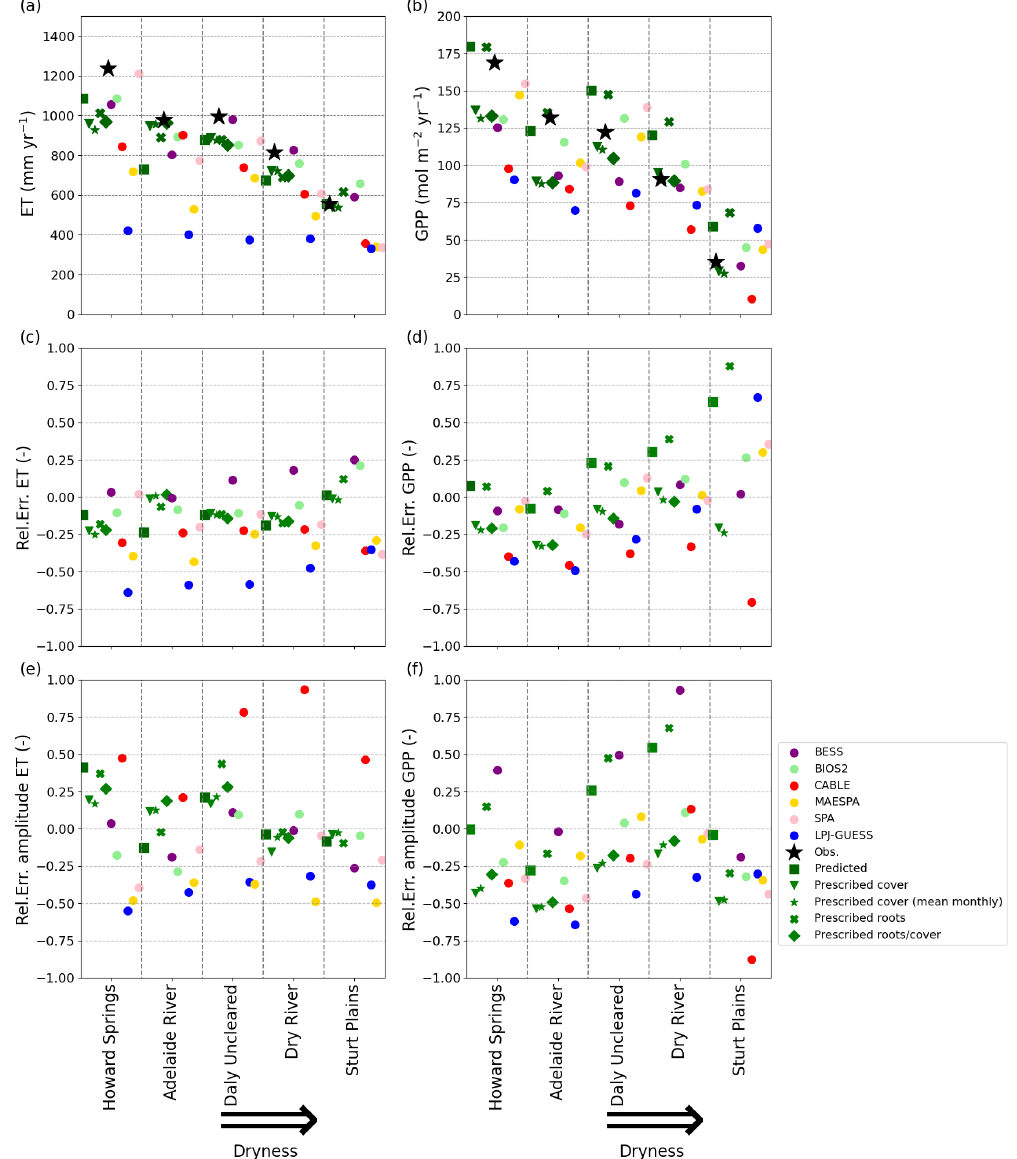
Figure 3. Performance of the VOM, the VOM with prescribed cover, prescribed roots, prescribed roots and cover, and the models analysed by Whitley et al. (2016) in comparison with flux tower observations. (a, b) : mean annual ET and GPP; (c, d) : the relative error of the mean annual ET and GPP; (e, f) : the relative error for the mean seasonal amplitude of ET and GPP. All metrics for all models are calculated for the overlapping time period of the model time period and the flux tower time period for each site (see Table S8.1 in Supplement